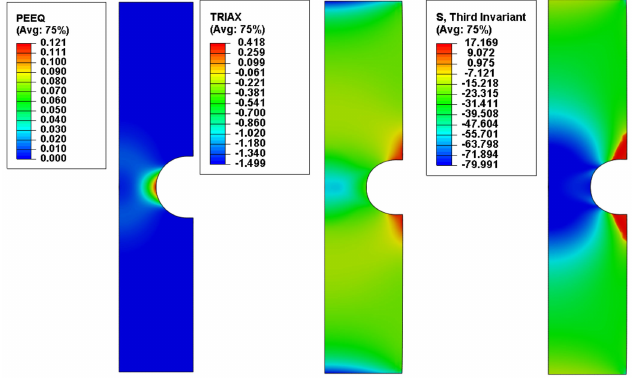
Figure 11. Equivalent plastic strain, stress triaxiality and normalized third invariant distribution for the upsetting tests specimens of 3.33 mm radius.